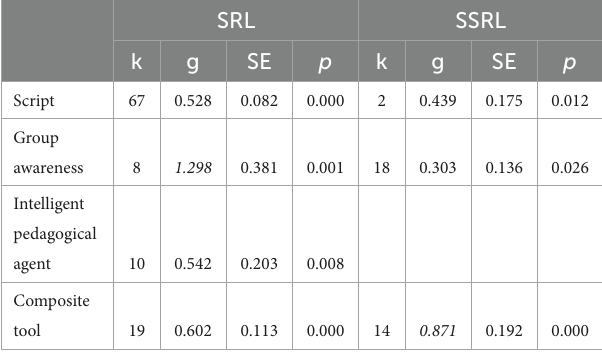
TABLE 6 Scaffolding’ effects by type of regulated learning.